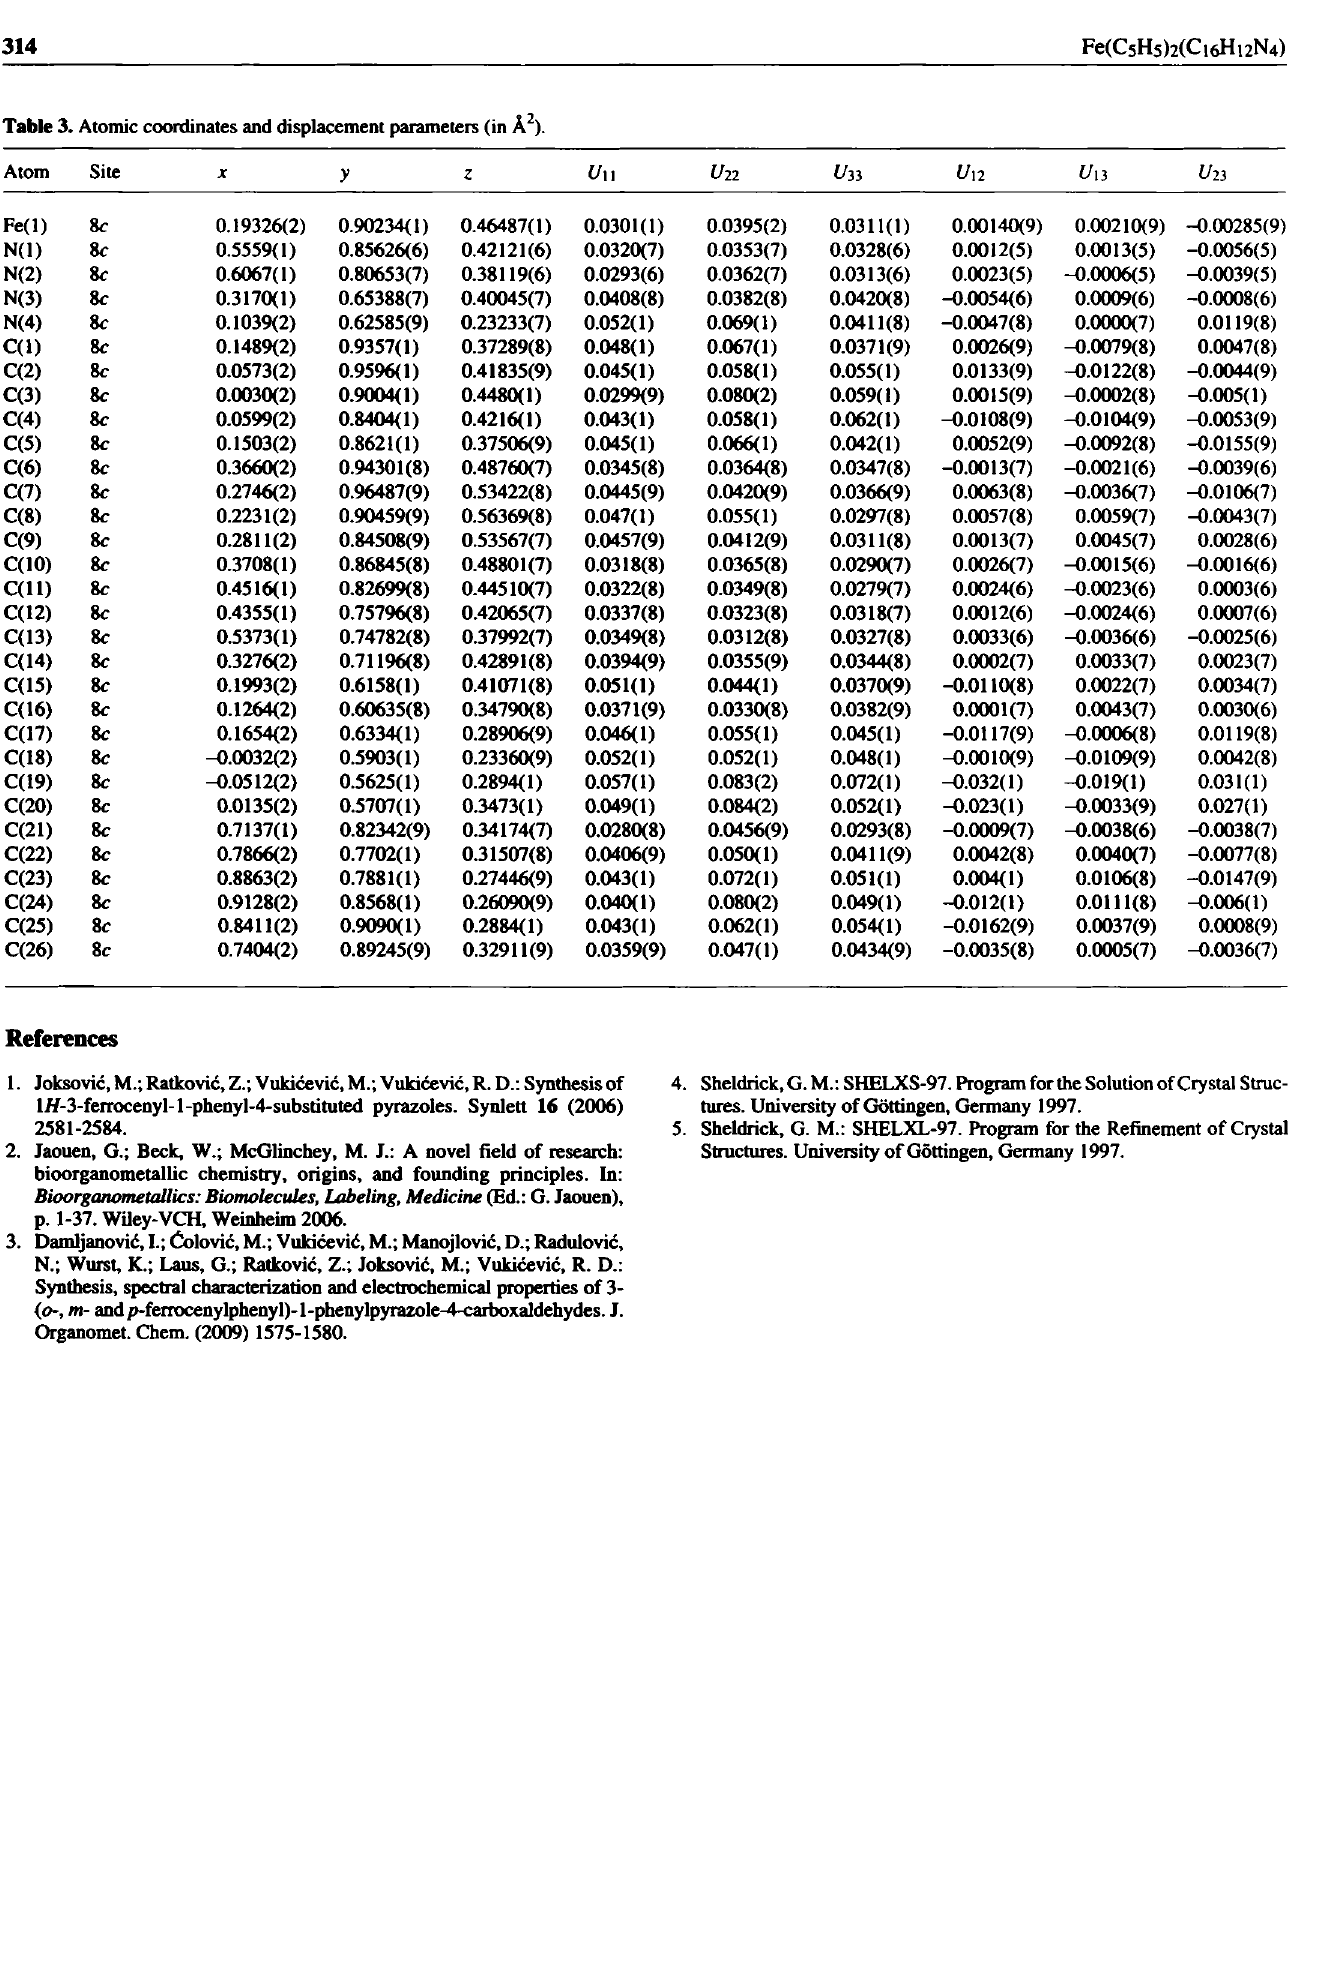
Table 3. Atomic coordinates and displacement parameters (in Â 2